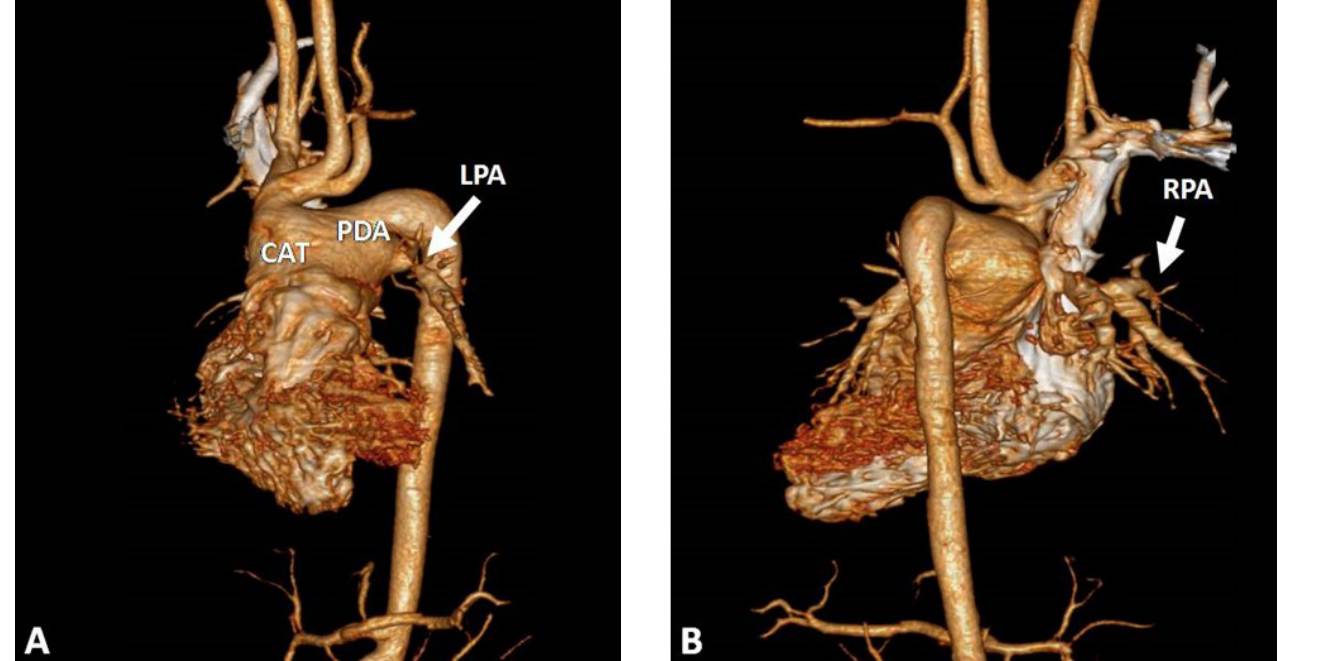
Fig. 1 - Three-dimensional volume-rendering computed tomography angiography: A) Common trunk with type A interrupted aortic arch showing a large patent ductus arteriosus (PDA) that continues to the descending aorta. Banded and very hypoplastic left pulmonary artery (LPA) (2 mm). B) Banded and very hypoplastic right pulmonary artery (RPA) (1 mm) originated from the sides of the common trunk as the LPA, with significant distance between them. CAT=common arterial trunk